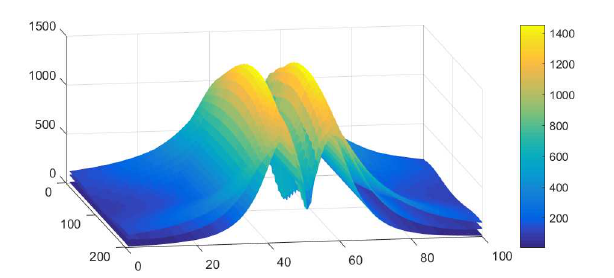
Figure 14. 3D view of electric field intensity of CSM, OCSM, and FEM.